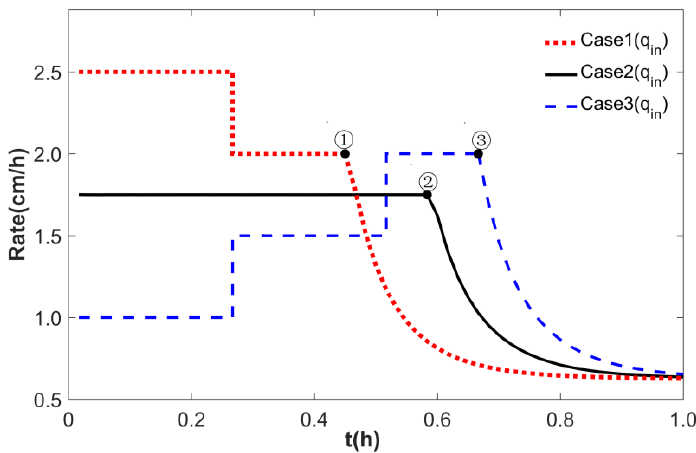
Figure 9. Surface infiltration rate under three different rainfall intensity conditions.